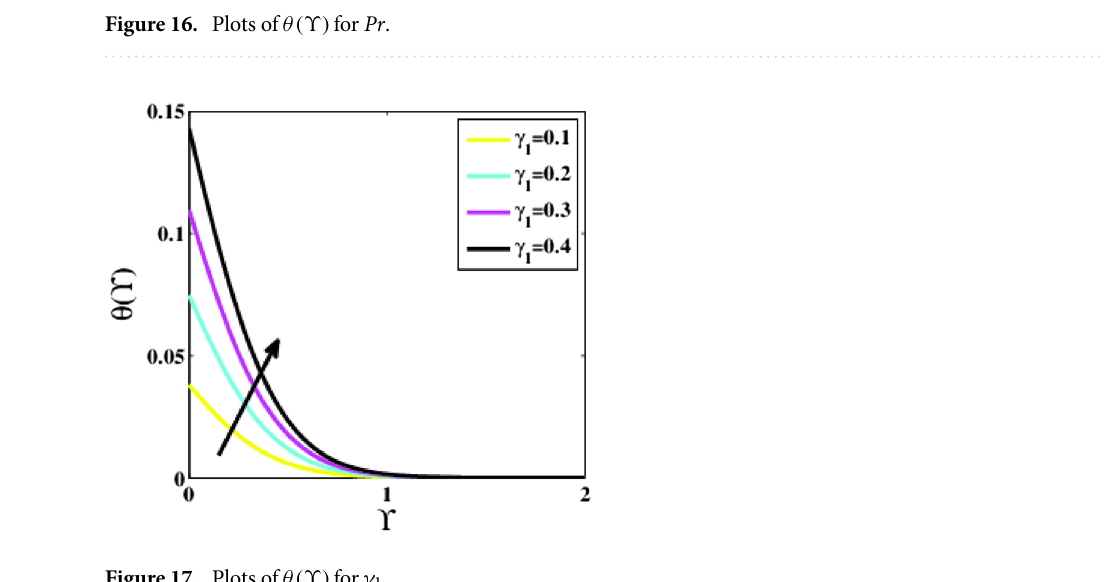
Figure 17. Plots of θ(ϒ) for γ 1 .